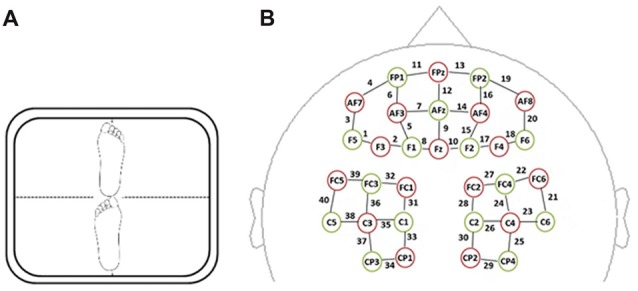
(A) Tandem barefoot standing postural control task scheme. The side of the heel of one foot was touching the big toe of the other. (B) Spatial profile of functional near-infrared spectral imaging (fNIRS) probes. The red circles indicate the 16 optical sources, the green circles indicate the 15 detectors, and the black numbers (1–40) indicate fNIRS channels. The optical sources and detectors were positioned on the international 10–20 standard positions.